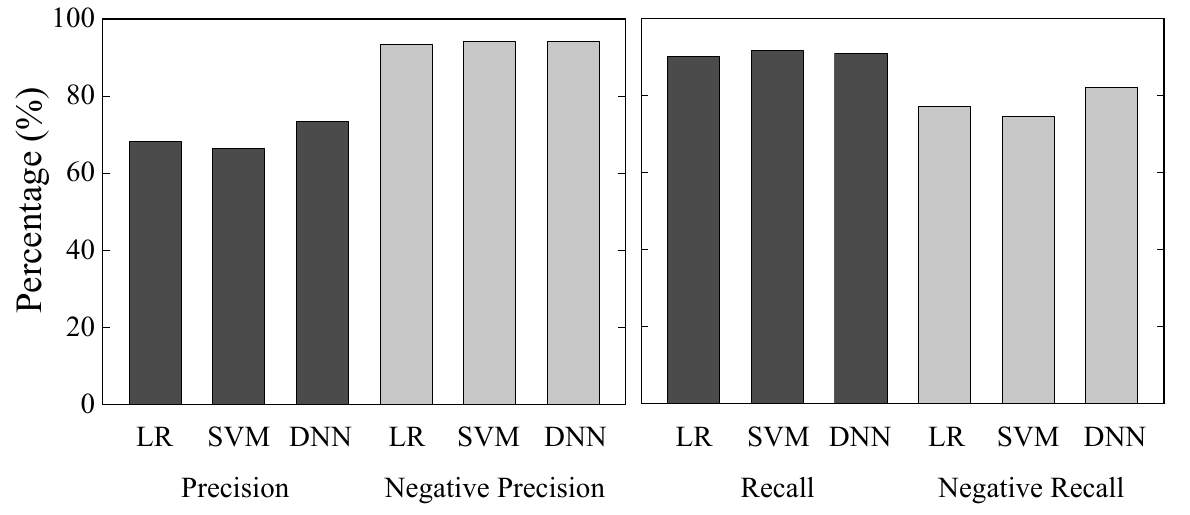
Figure 6. Comparison of Precision, Negative Precision, Recall, and Negative Recall in Section 3.3.